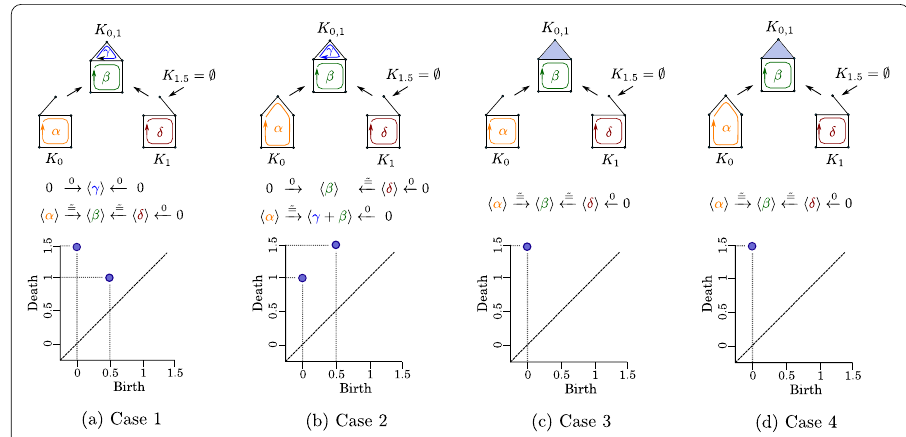
Figure 3 Several examples showing how the zigzag persistence diagram can be affected by the existence of small loops. The first and third; and the second and fourth examples have the same filtration with the addition of a single triangle in the later case. In each case, the generators of homology are shown with the interval decomposition drawn below. The resulting persistence diagrams show that the third and fourth examples show a single bar representing the persisting loop. However in the first two intervals are quite different, where the long lived bar is split into two pieces in the second example